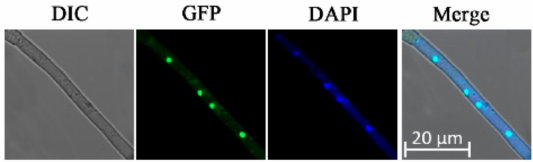
Figure 4. Subcellular localization of AaBre1 in A. alternata . AaBre1 was mainly localized to the nucleus. 4’6-diamidino-2-phenylindole (DAPI) was used to observe nuclei. Di ff erential interference contrast (DIC); bars, 20 µ